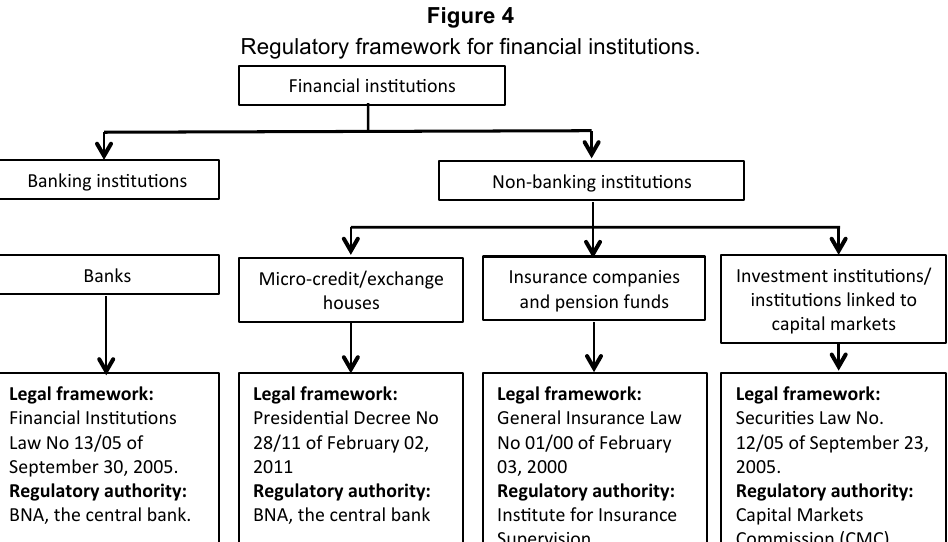
Regulatory framework for financial